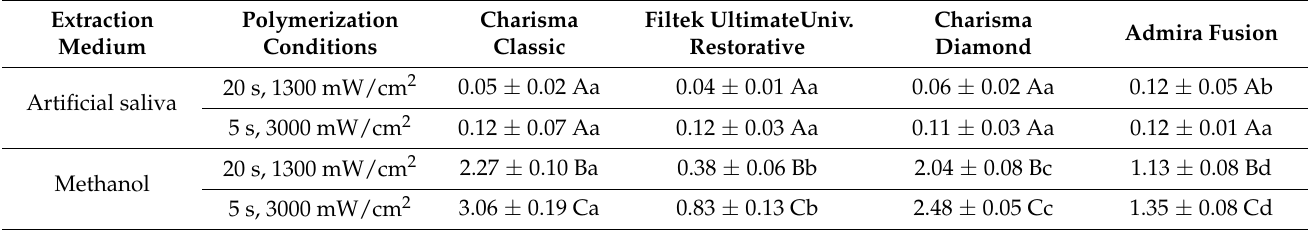
Table 6. The mass loss of the tested composites (mean ± SD in